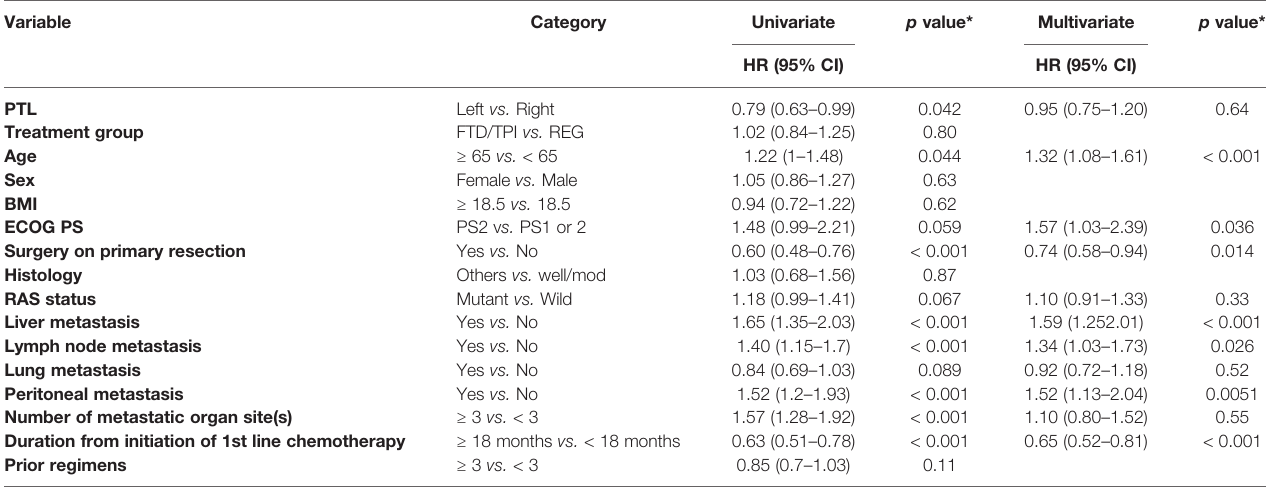
TABLE 1 | Patient characteristics. TABLE 2 | Univariate and multivariate analyses of overall survival (OS) in the observational cohort. Variable